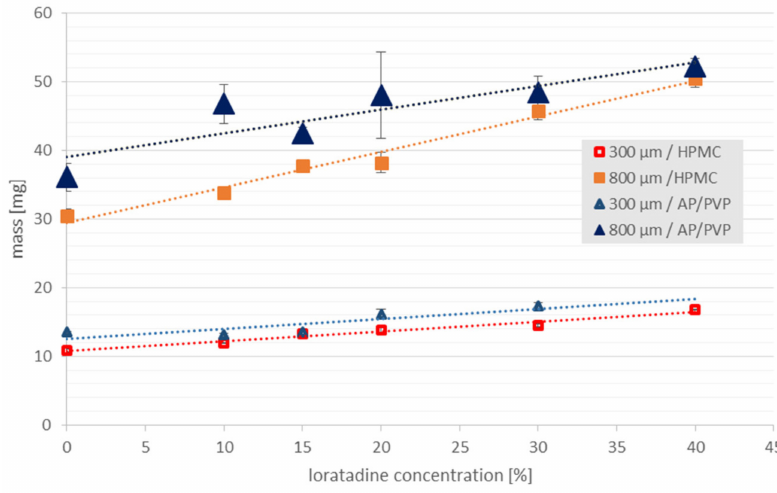
Figure 6. Correlation between solid particles loading (LO 10%–40% w / w ) and the mass of the ODFs (3 cm 2 ) prepared with the HPMC or AP / PVP matrix (casting heights of 300 µ m and 800 µ